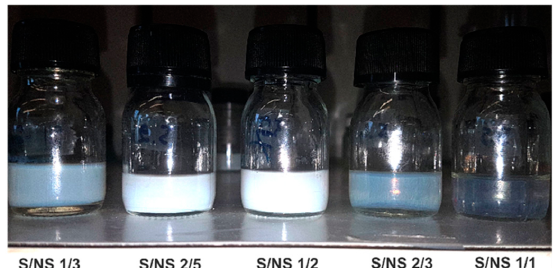
Figure 4. The variation in color of 1% BSA formulations at different S/NS volume ratios. For further investigation, the variation of both particle size and zeta potential was studied as a function of S/NS ratio for all the BSA concentrations used in this study. Figure 5A shows the relation between nanoparticle size and S/NS for different BSA concentrations after the evaporation of ethanol. For all BSA concentrations, the size of nanoparticles increased by 50 nm with an increase in the S/NS ratio from 1/3 to 1/2. The successive increase in S/NS ratio (i.e., > 1/2) led to a significant reduction in size to reach its minimum for all BSA concentration at S/NS ratio of 1/1 (Figure 5A). This alternating behavior in size could explain the color fading observed in Figure 4.